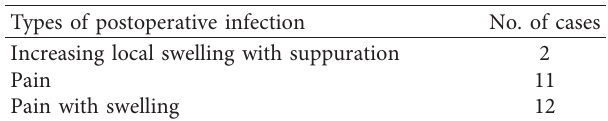
Table 3: The types of postoperative infection for the 25 postop- erative infection cases.